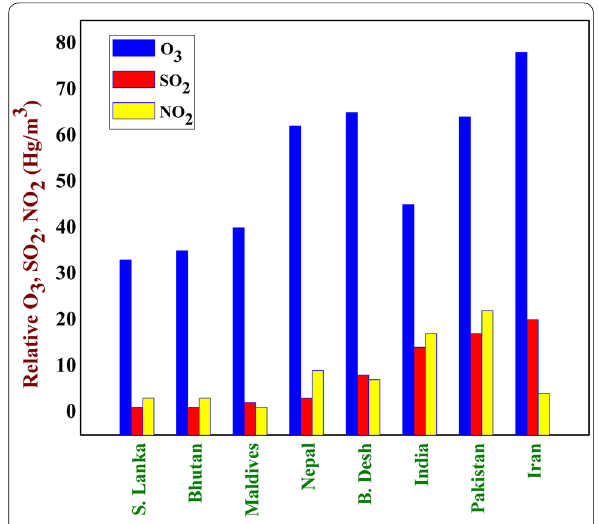
Fig. 3 Relative pollutions in SARC